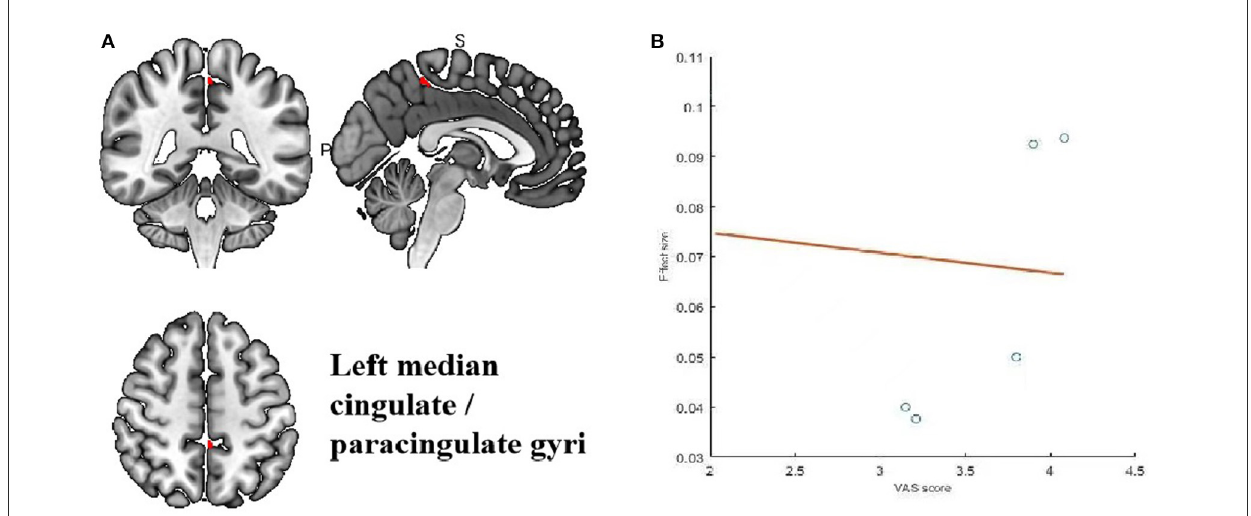
FIGURE5 Results of Meta-regression linear model analysis. (A) VAS scores of migraine patients are positive correlated with regional activity in the Left median cingulate/paraxingulate gyri. (B) The effect sizes needed to create this plot were extracted from the peak voxels of the maximum slope difference. All studies are indicated by the empty blue circles. Regression lines (Meta-regression SDM slopes) are shown as straight